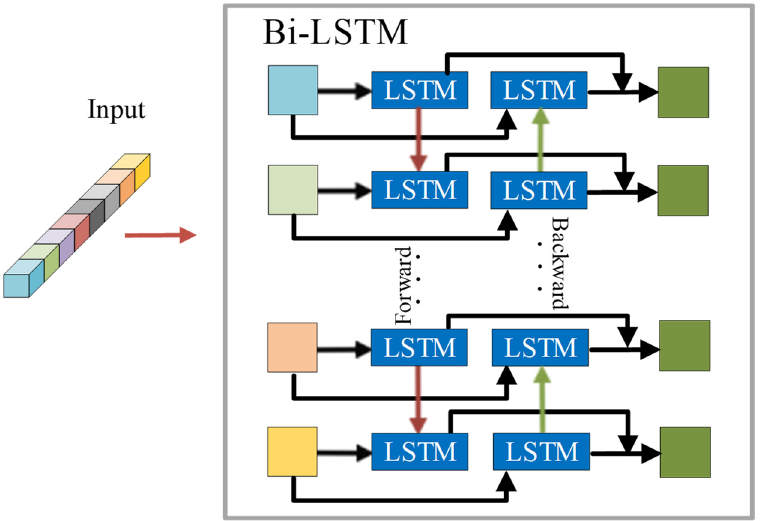
Figure 5. Bi-LSTM framework diagram.